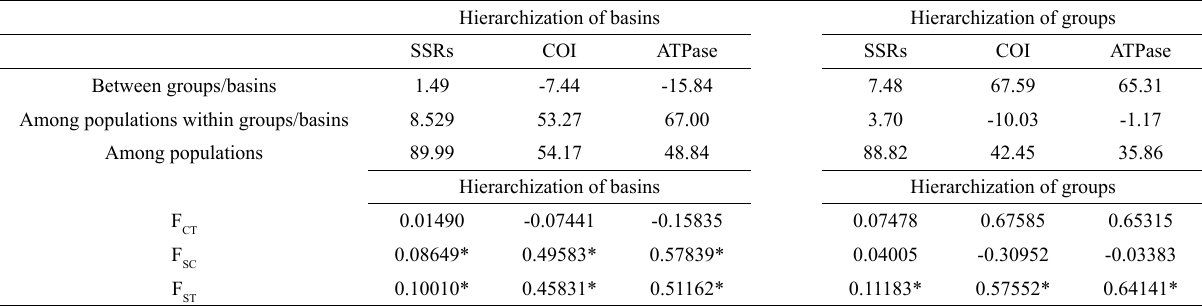
Table 3 – Values of the genetic variation of three markers (Microsatellites, COI, and ATPase) obtained through AMOVA under two hypotheses of hierarchical data (Sapucaí and Paraíba do Sul Basins and groups – PE+LV+RG, CP, and RP).